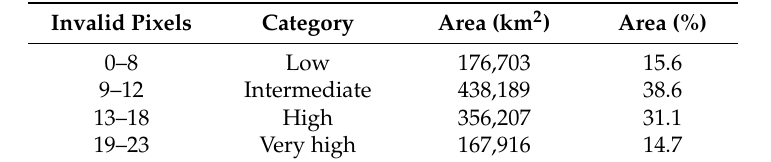
Figure 2. Temporal distribution of invalid pixels. ( A ) Average of 23 16-days composites per year describing inter-annual variability of invalid data from 2001 to 2013. The inter-annual average is 50.4%; and ( B ) temporal distribution of invalid data in 2011 with a dry season at the beginning of the year (date 1) and at the end of the year (date 23), with two rainy seasons separated by a semi-dry season (dates 13–19). The percentage of invalid pixels ranges from a minimum of 26% (January) to a maximum of 87% (April) with an average of 54.9%. The spatial distribution of invalid pixels is related to the cloud formation [38], by wind convergence over the Pacific Ocean and the orographic effect of the Andes (Figure 3A shows data for 2011). This map was regionalized in four categories, low, intermediate, high, and very high (see Figure 3B) defined by natural breaks (Jenks) unsupervised classification method (Table 4). Table 4. Categorization of invalid pixels of 2011 in four classes (low, intermediate, high, very high) using thresholds according to natural breaks (Jenks) unsupervised clustering.